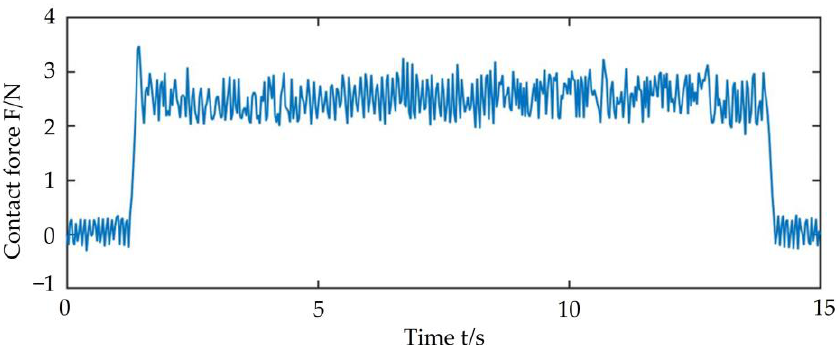
Figure 13. The change in contact force with time in the process of polishing complex curved plexiglass part with 400 # sandpaper.